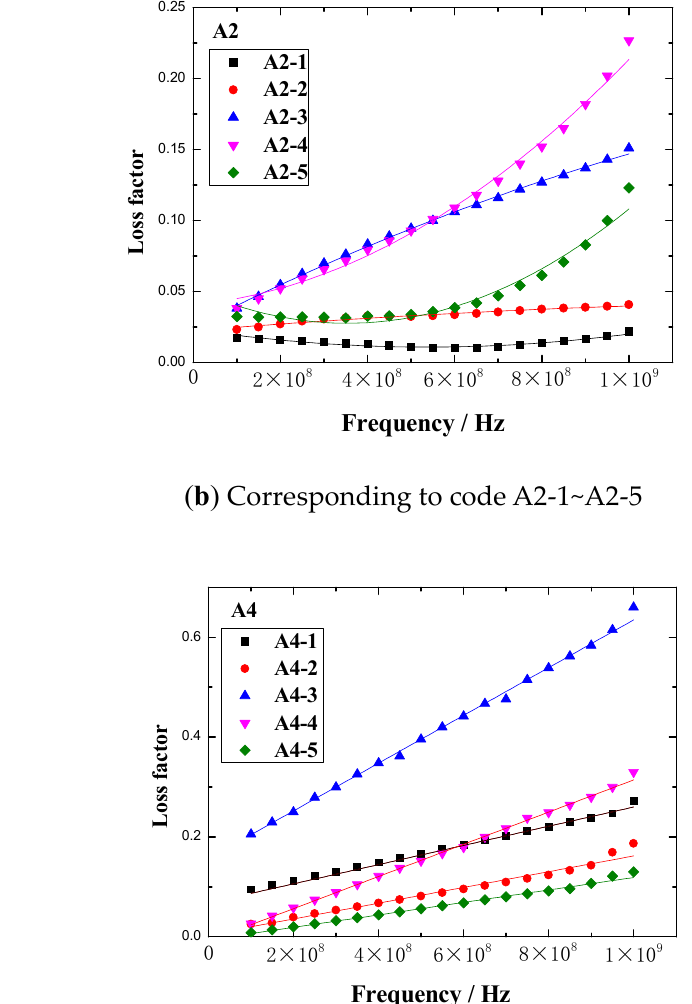
Polymers 2021 , 13 , 2908